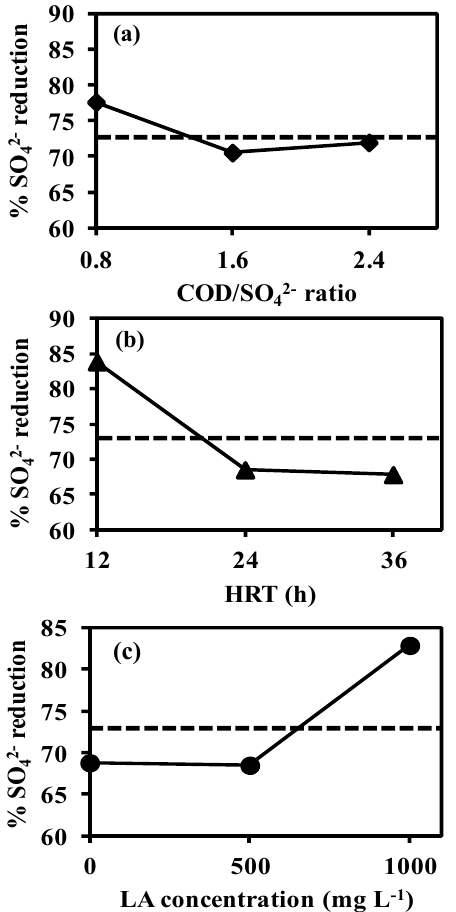
Figure 2. Impact of selected experimental factors on percent sulfate reduction. ( a ) Effect of COD/SO 42 − ratio; ( b ) Effect of HRT; ( c ) Effect of LA